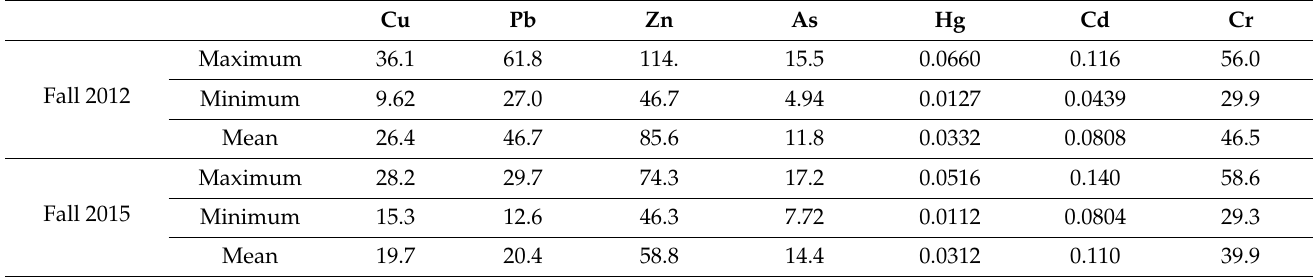
Table 2. Statistical results of the heavy metal content in the